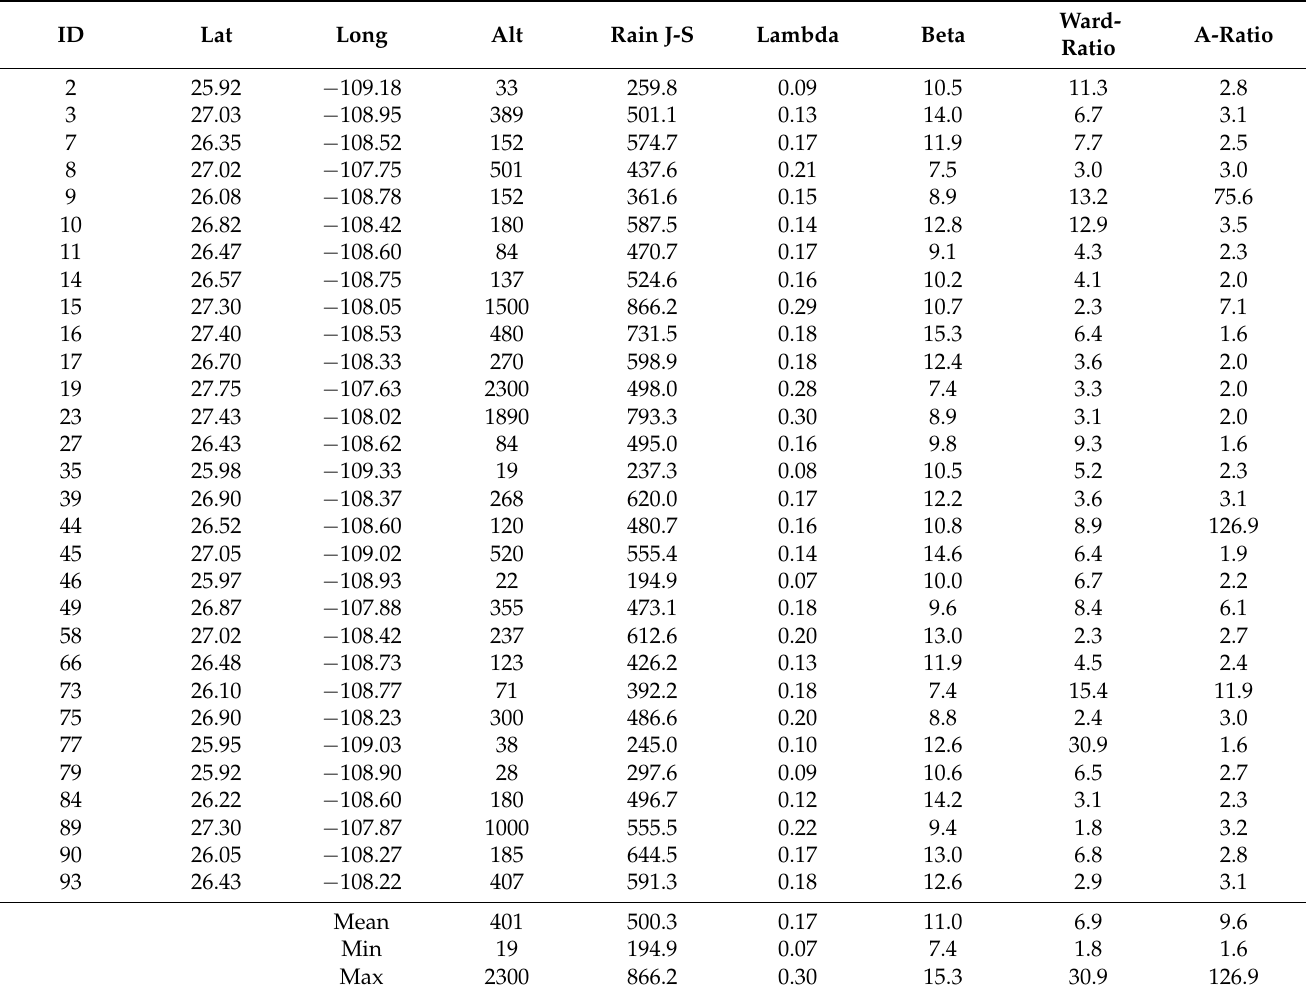
Table A1. Region I: Transition zone to the Chihuahua